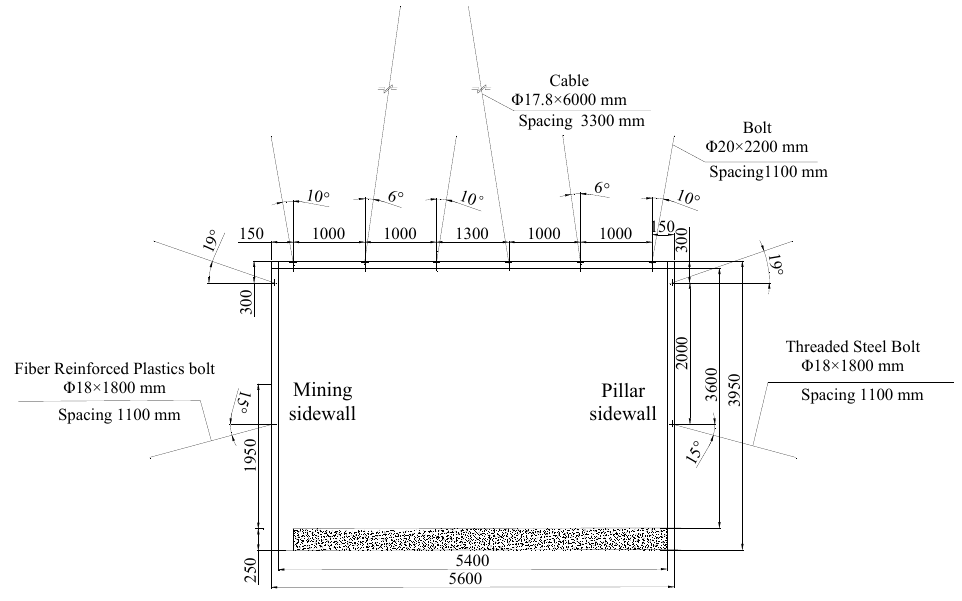
Figure 4. Original support scheme of RAR 23205.